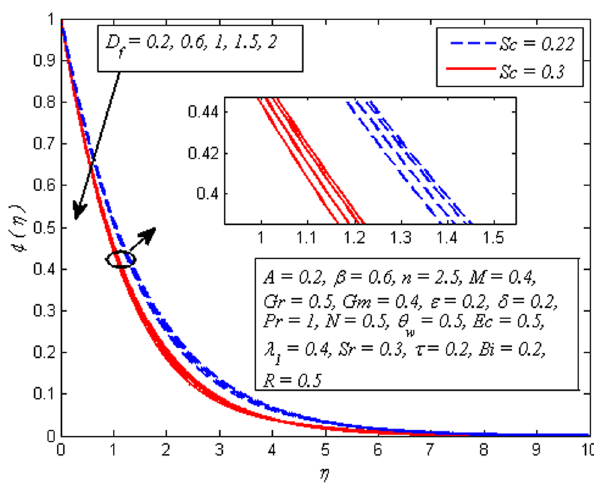
Figure 22. Effect of D f on concentration for different Sc